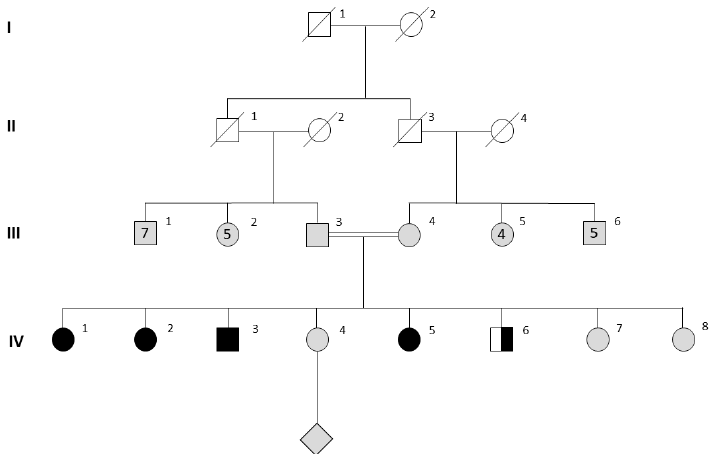
Figure 1. Pedigree of a consanguineous kindred with MCM9 pathogenic variant. Males and females are designated by squares and circles, respectively. In generation III, the numbers of offspring are indicated by Roman numerals inside the squares/circles, the diamond refers to multiple offspring of individual IV-4 Homozygotes for the MCM9 pathogenic variant are shown in black, heterozygotes in black and white, untested subjects in grey and deceased individuals in white with a strikethrough.